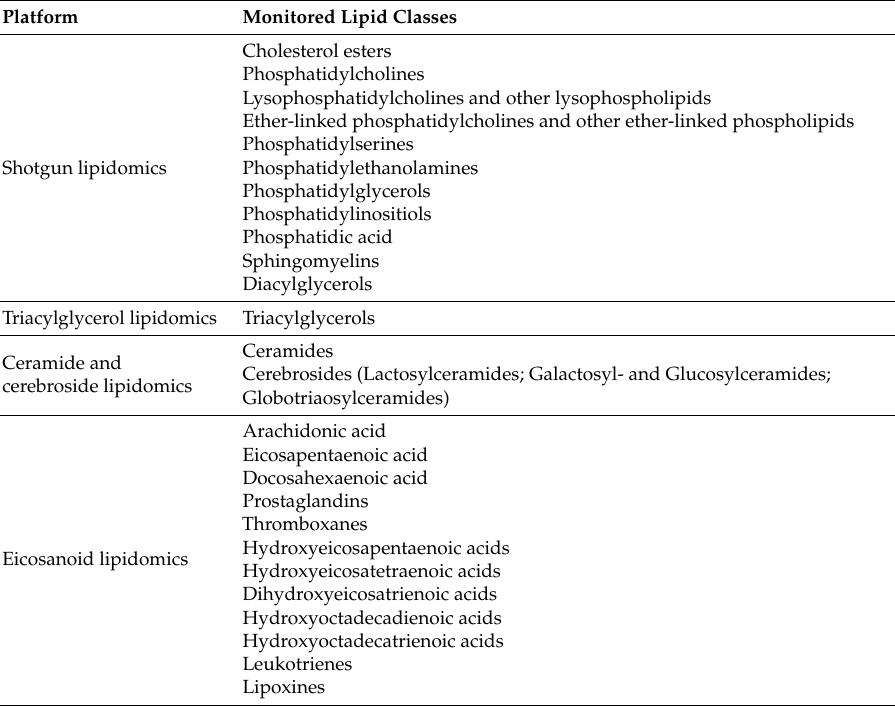
Table 2. Mass spectrometry-based lipidomics platforms used in this